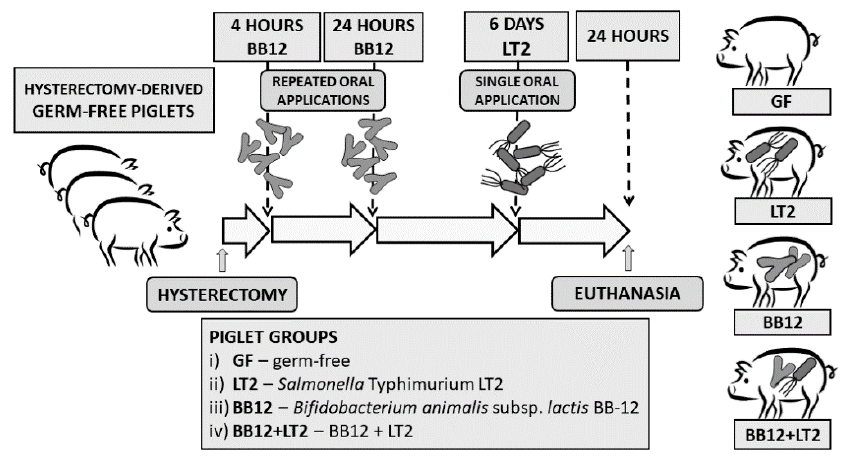
Figure 9. Experiment design. Preterm gnotobiotic piglets ( n = 24) were assigned into four groups with six piglets per group: (i) germ-free (GF), (ii) infected with Salmonella Typhimurium strain LT2 (LT2), (iii) associated with probiotic Bifidobacterium animalis subsp. lactis BB-12 (BB12), and (iv) associated with BB12 and infected with LT2 (BB12 + LT2).